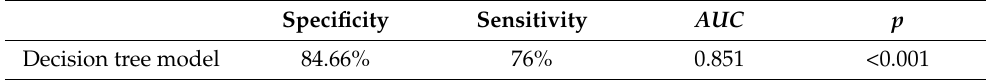
Table 7. Prediction accuracy of the decision tree model.